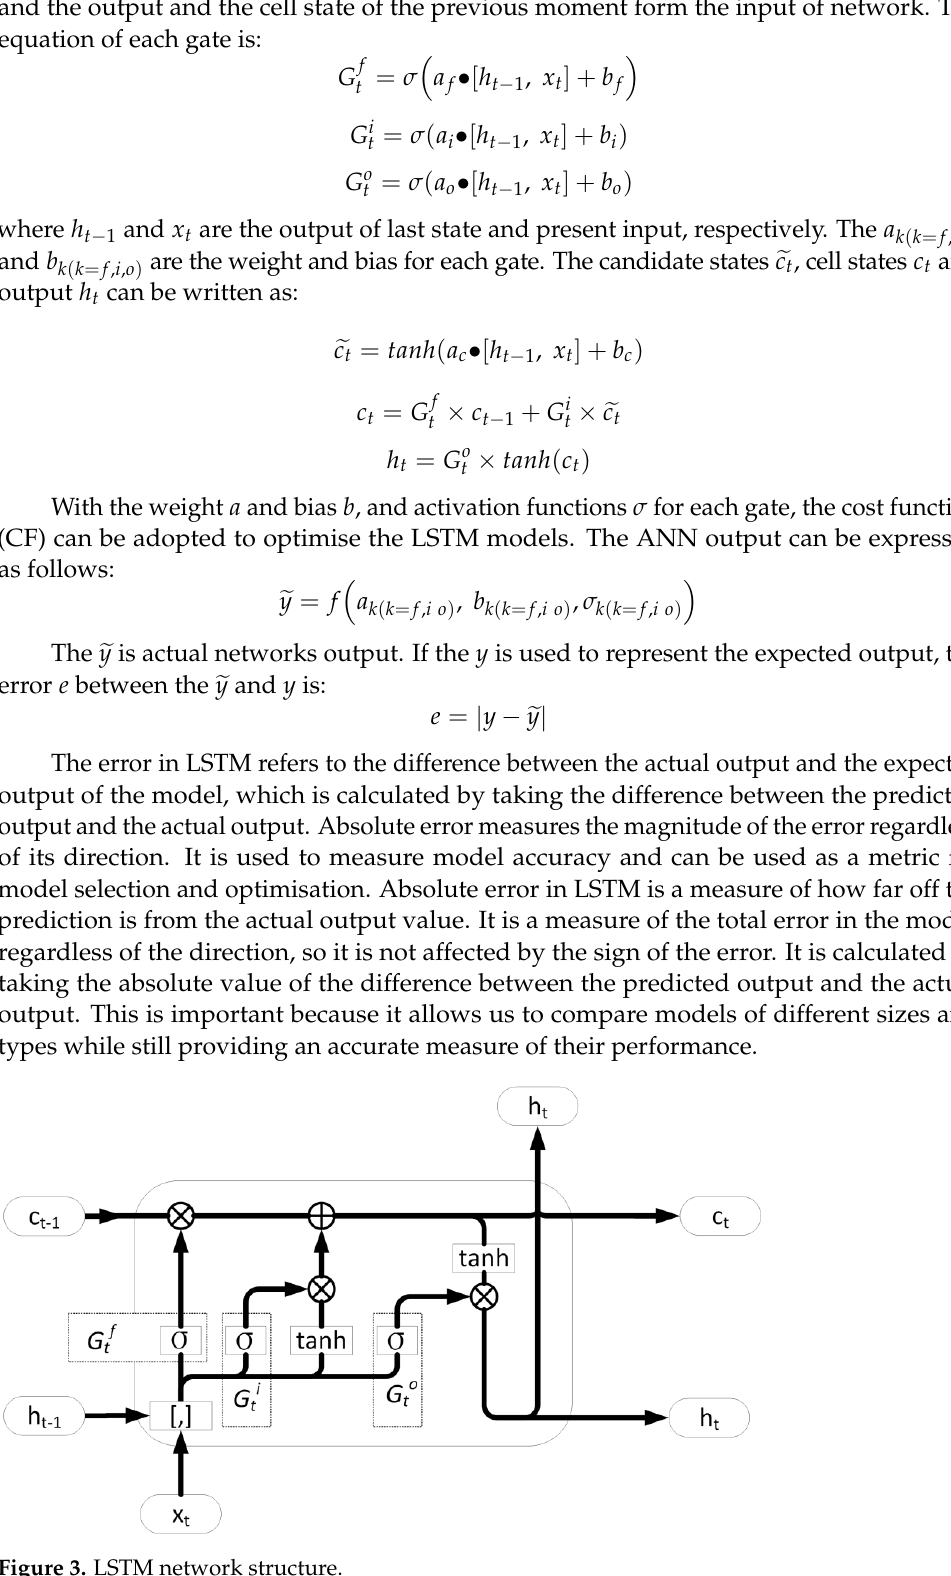
Figure 3. LSTM network structure.